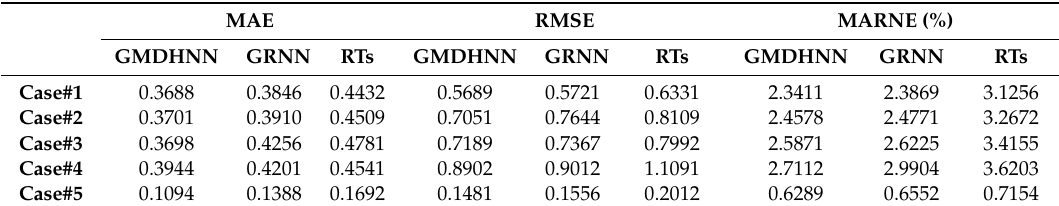
Table 3. Evaluation of Group Method of Data Handling (GMDH), Regression Neural Network (GRNN), and Regression Trees (RTs) considering the 1-min-ahead horizon.